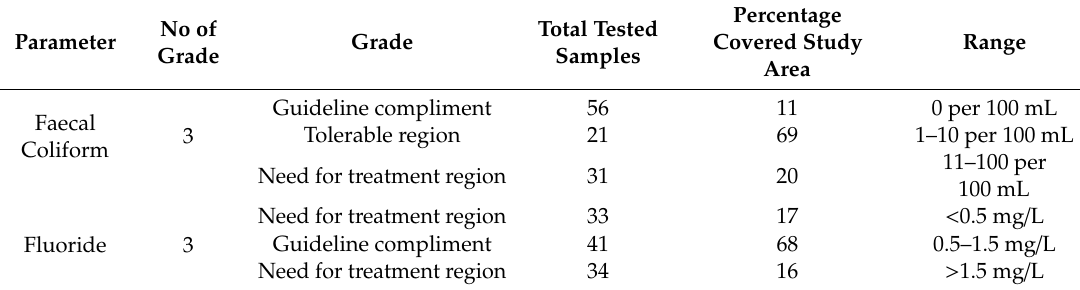
Table 4. Grading standard for potable water quality